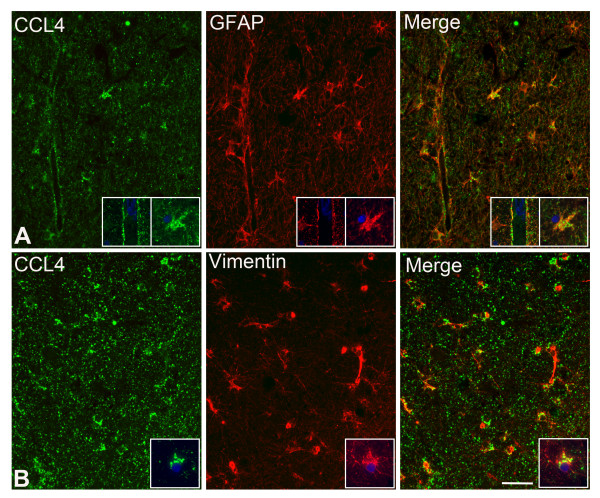
CCL4 IR in astrocytes and reactive astrocytes. IFC reveals CCL4 (in green) co-localizing with two types of glial cell markers (red), (A) astrocytic marker GFAP and (B) reactive astrocytic marker Vimentin. CCL4 IR is also present in the astrocytic endfeet of the GFAP positive astrocytes (A). Pictures are taken of representative areas in the CA4 region. The insets are higher power magnifications taken from the same anatomical area, with the added nuclear marker DAPI (blue). Scale bar = 40 μm